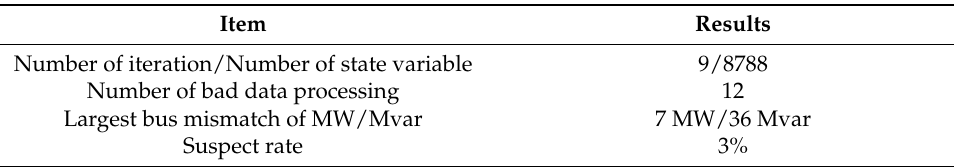
Table 14. Summary of the state estimation.